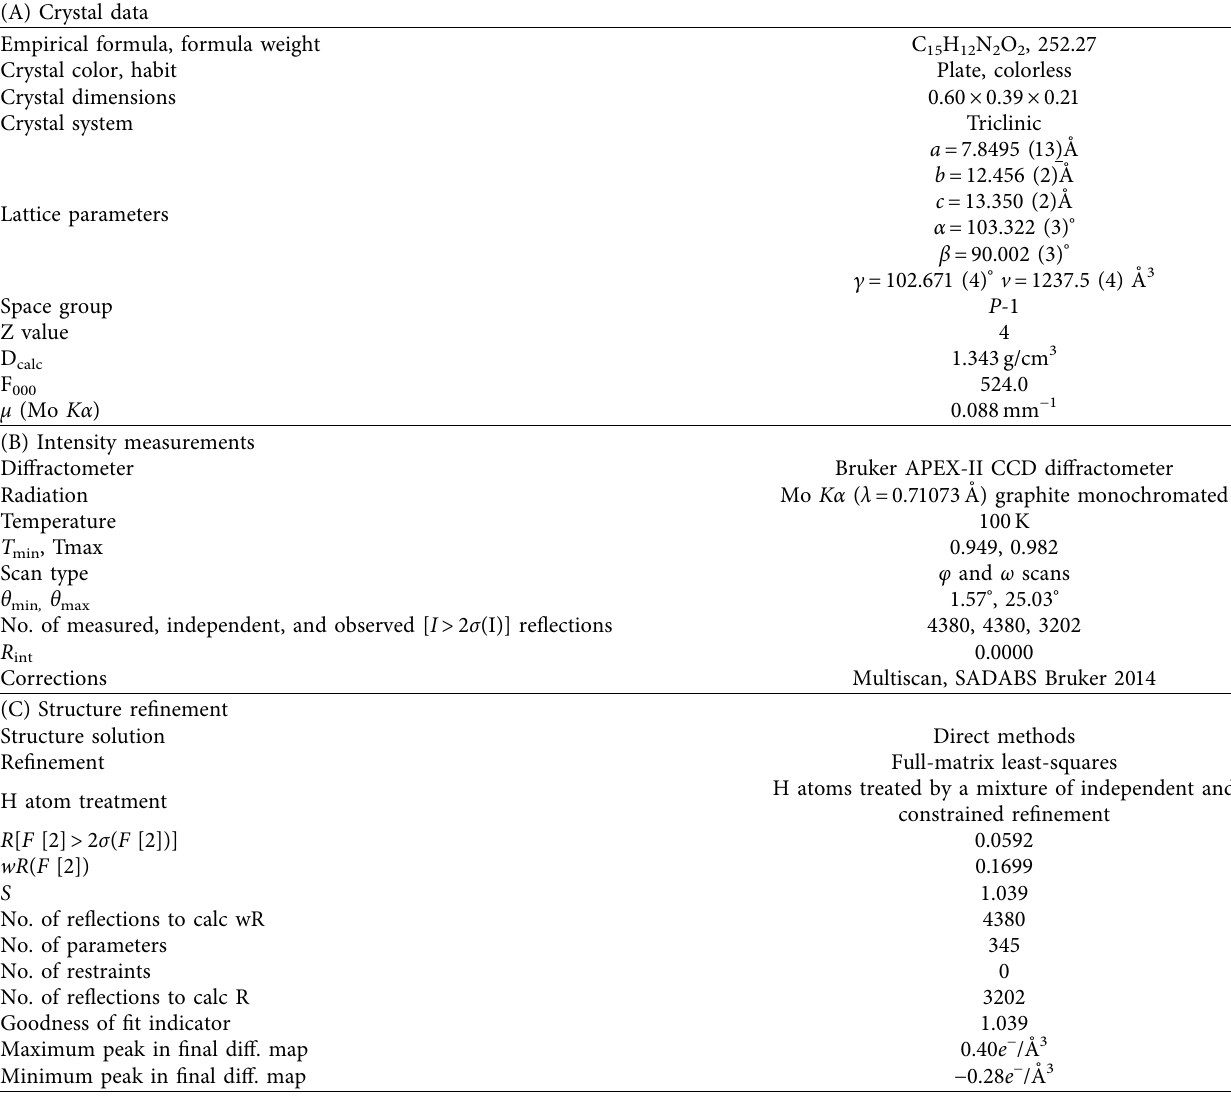
Table 3: Experimental X-ray details for the structure of 6-methyl-3-phenylquinazoline-2,4(1H,3H)-dione ( 11 ).